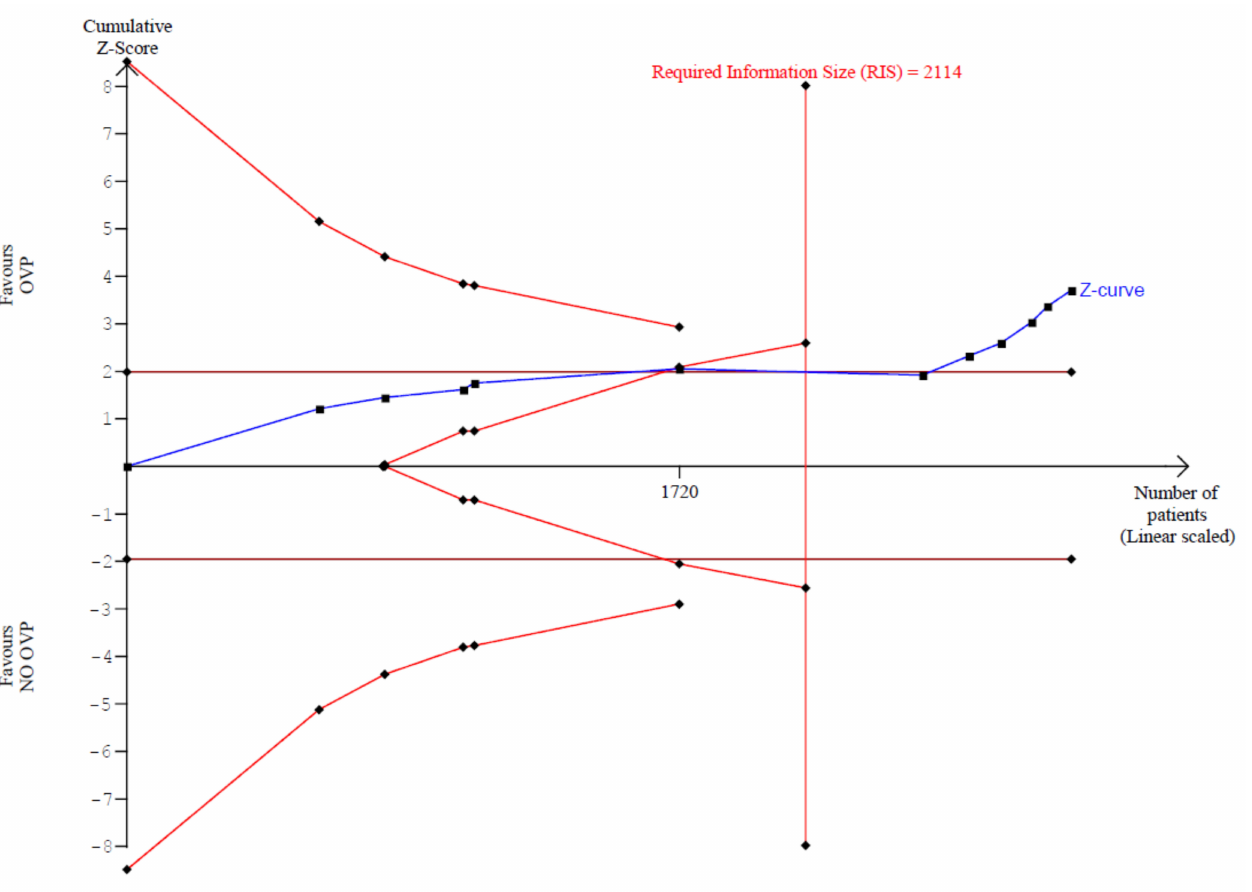
Figure 4. Trial sequential analysis of CDI onset comparing OVP with no active prophylaxis. Abbrevi- ations: OVP: oral vancomycin